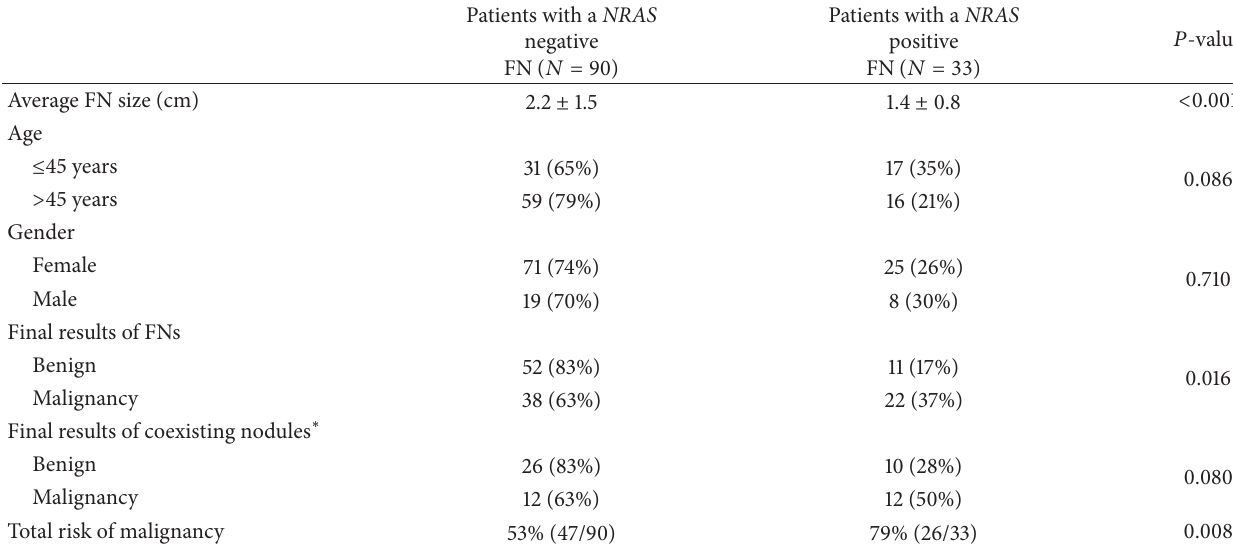
Table 1: Clinicopathological features and the NRAS mutation status of 123 follicular neoplasms (FNs).